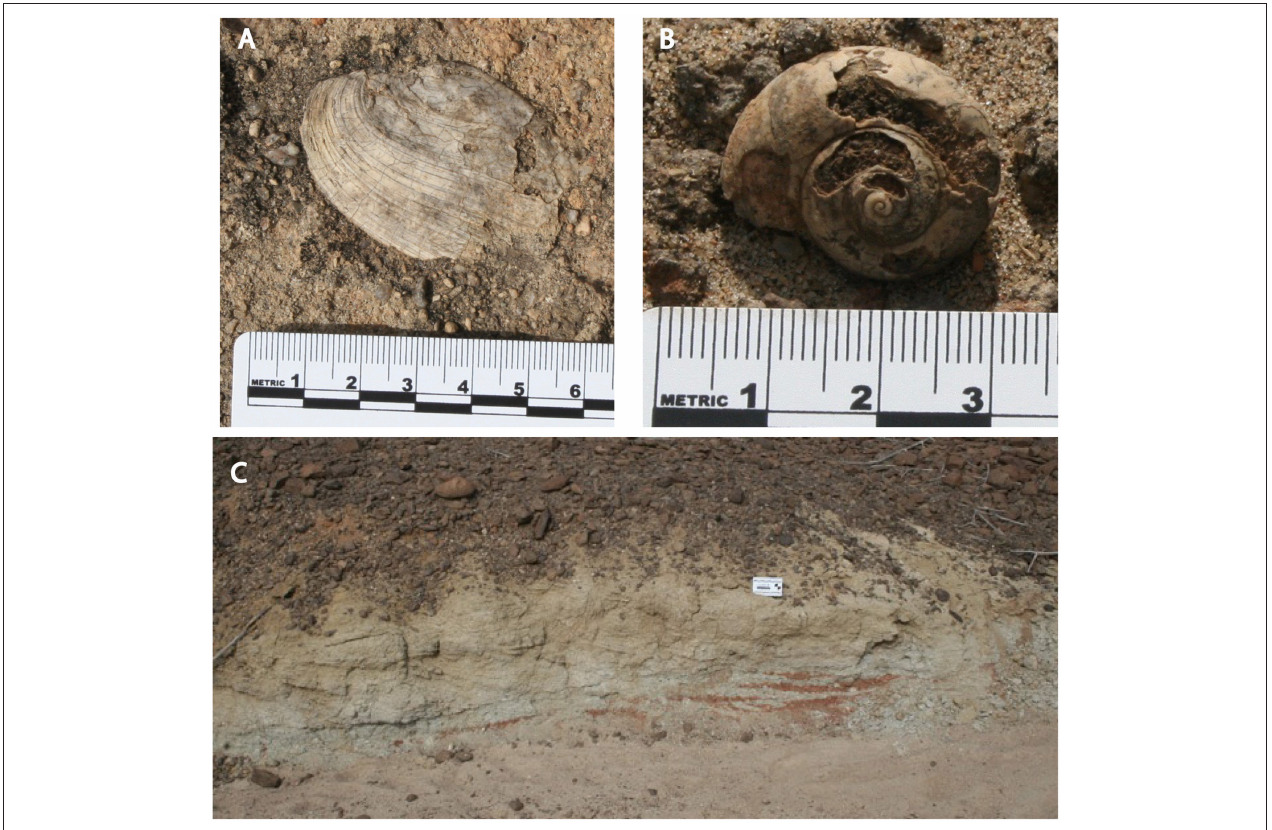
FIGURE 5 | (A,B) Fossil invertebrates found at Loperot: an unionid bivalve (cf. Coelatura ; A ); an aestivating ampulariid ( Lanistes sp.; B ). (C) Medium- to coarse-grained, crossbedded sandstones that show thin ( ∼ 10cm) fining upward sequences. Boundary between the crossbedded sandstone and red/gray siltstones beneath is erosional. Scale card is 8cm